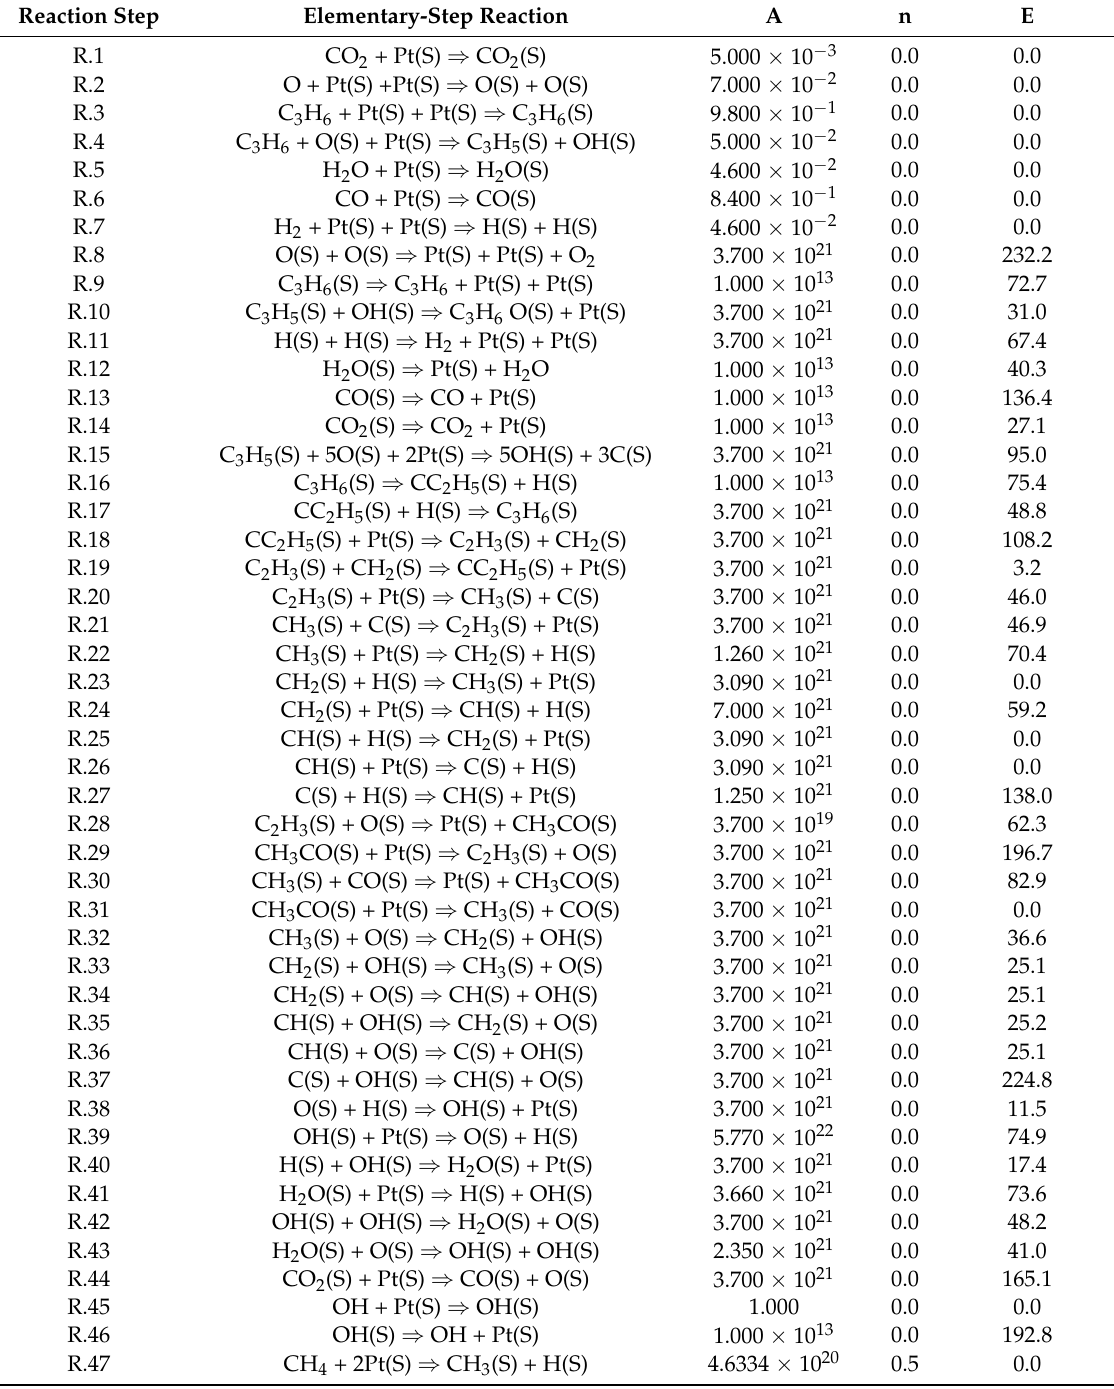
Table 2. Significant reactions and related rate constant expressions for propene surface